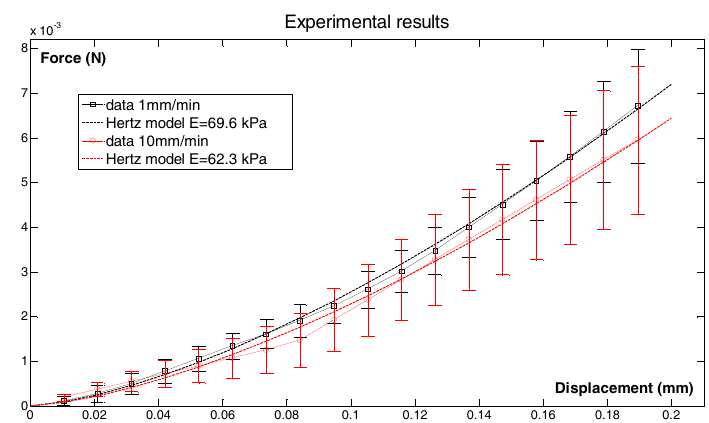
Figure 3. Mechanical features of HEMOCOLLAGENE ® . Force-displacement responses obtained using indentation tests at 1 mm/min ( n = 4) and 10 mm/min ( n = 4). The Young’s modulus has been identified using the Hertz model. No significant difference was observed between the two different testing speeds.